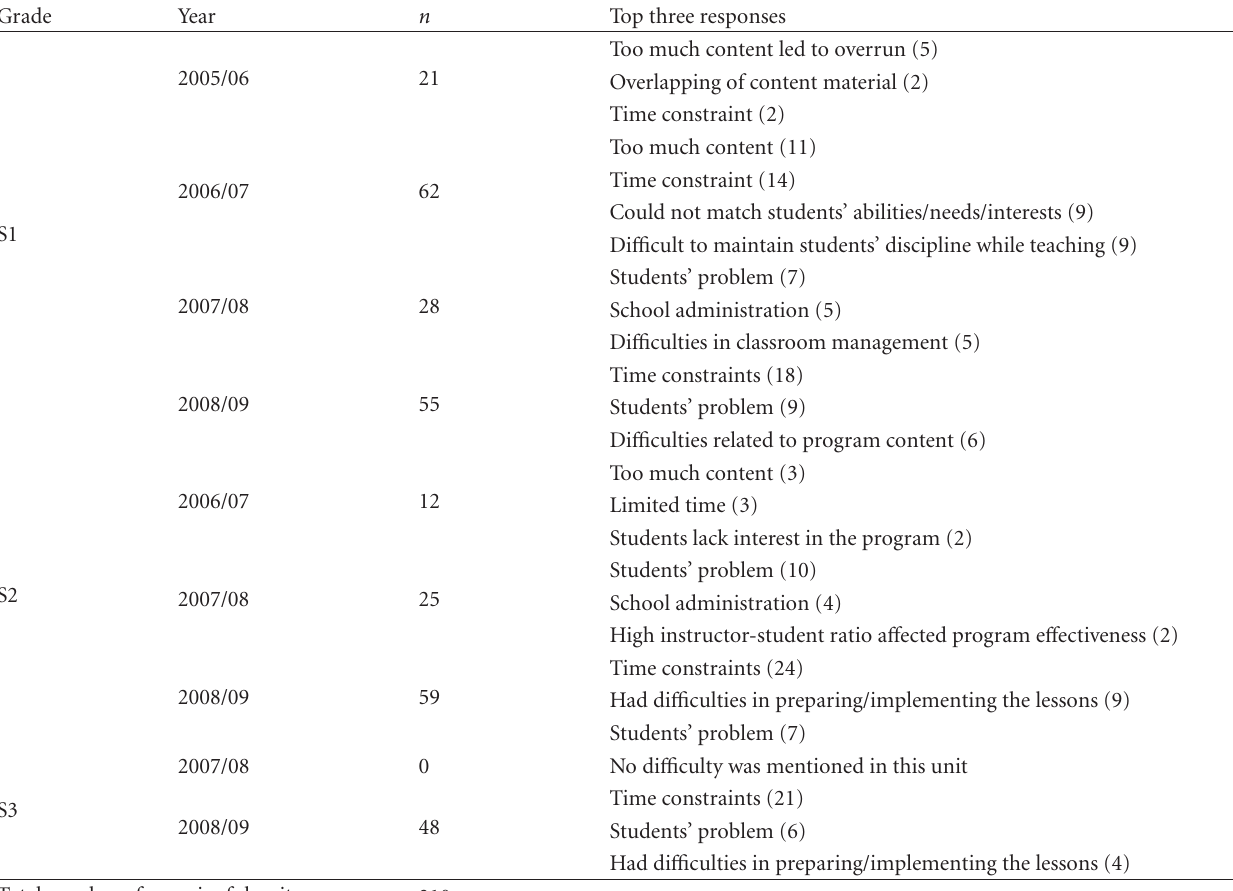
Table 5: Di ffi culties highlighted by the respondents in di ff erent